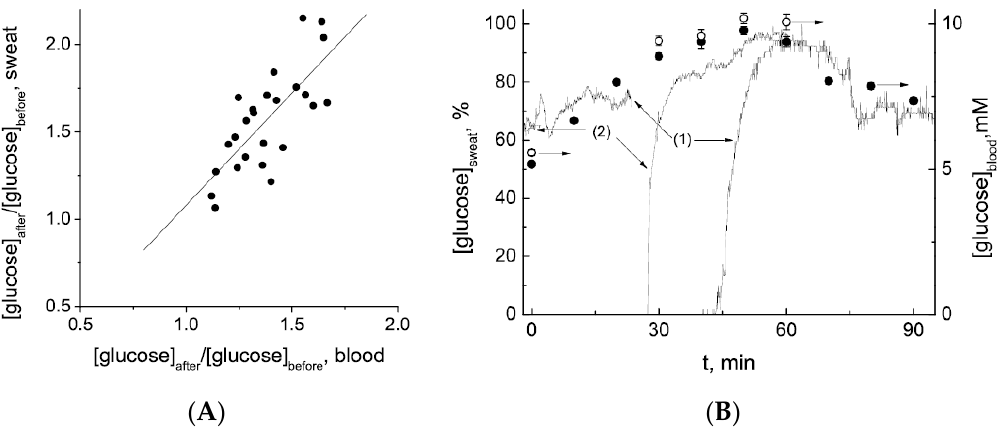
Figure 11. ( A ) Correlation in ratios of glucose content after glucose loading to the corresponding value before loading, for sweat and blood. Pearson coefficient r = 0.75. ( B ) Normalized sweat glucose level (solid lines) in comparison with blood vein glucose (circles) during a glucose tolerance test. The black and white circles correspond to two different measures. Curve 2 was obtained on a patient whose sweat has not been stimulated beforehand (sweat stimulation took about 25 min), while curve 1 was obtained on a patient whose sweat has been stimulated well before the glucose test. The breaks in the curves correspond to a second sweat stimulation. Reproduced from [45] with permission. Copyright © 2019 American Chemical Society.